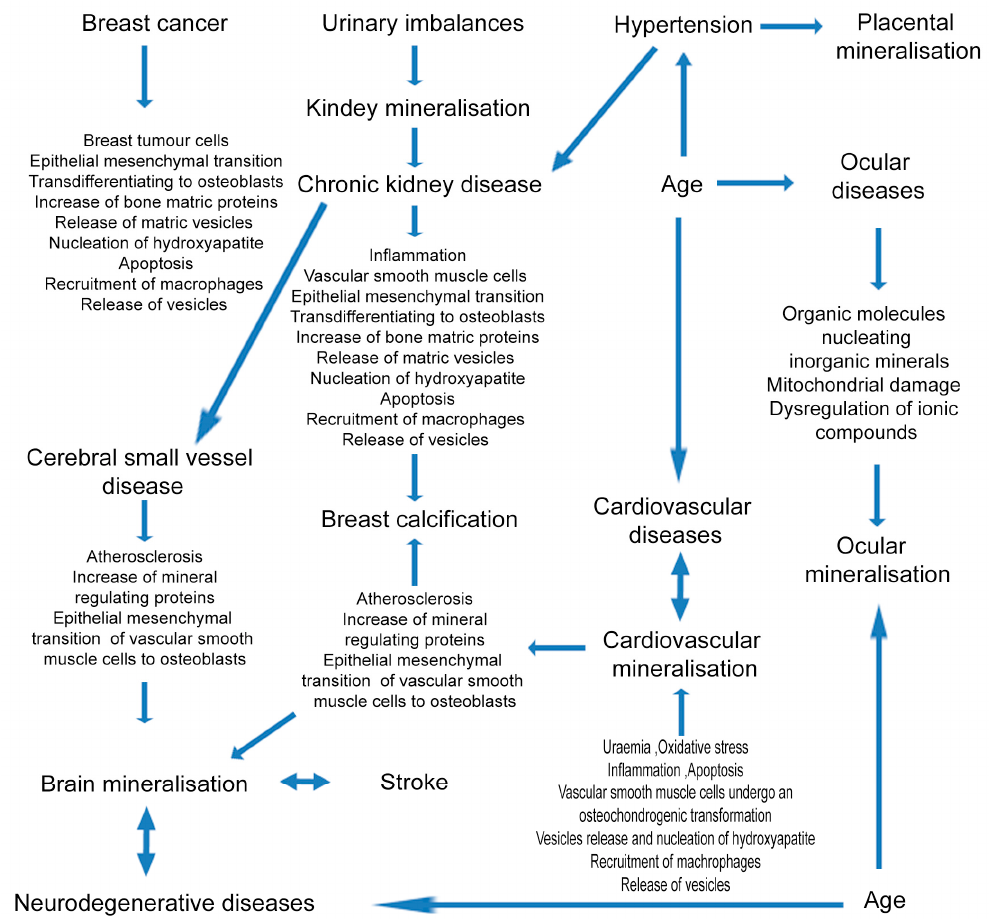
Figure 6. Schematic diagram of a range of pathologies and factors leading to mineralization in different parts of the body, including the proposed mechanisms responsible for mineral formation.